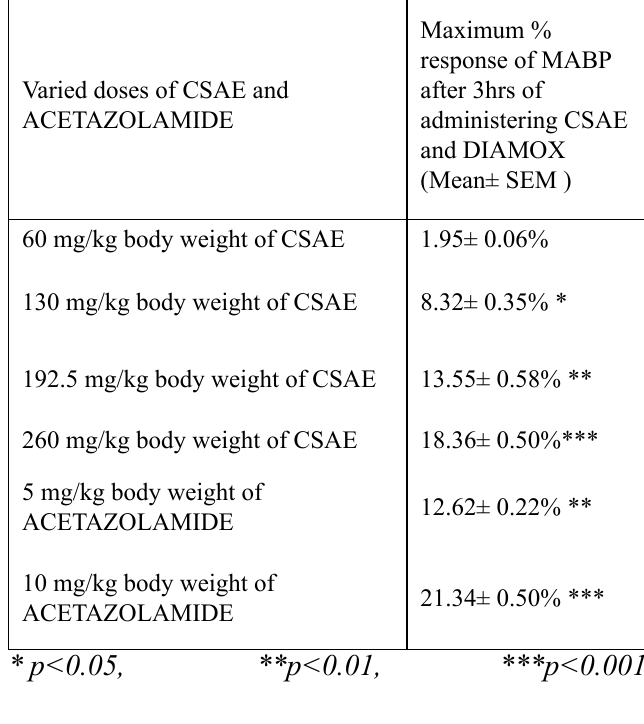
Varied doses of CSAE and